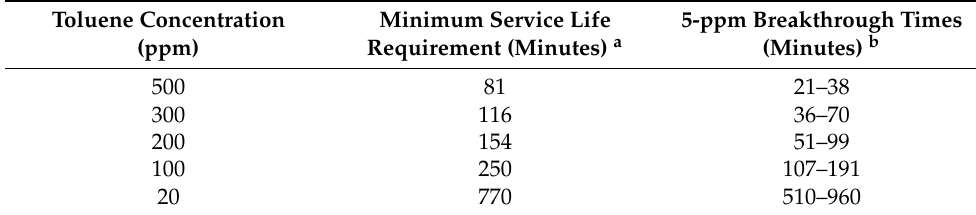
Table 3. Minimum service life requirement and experimental 5 ppm breakthrough times per organic vapor cartridge by toluene concentration.